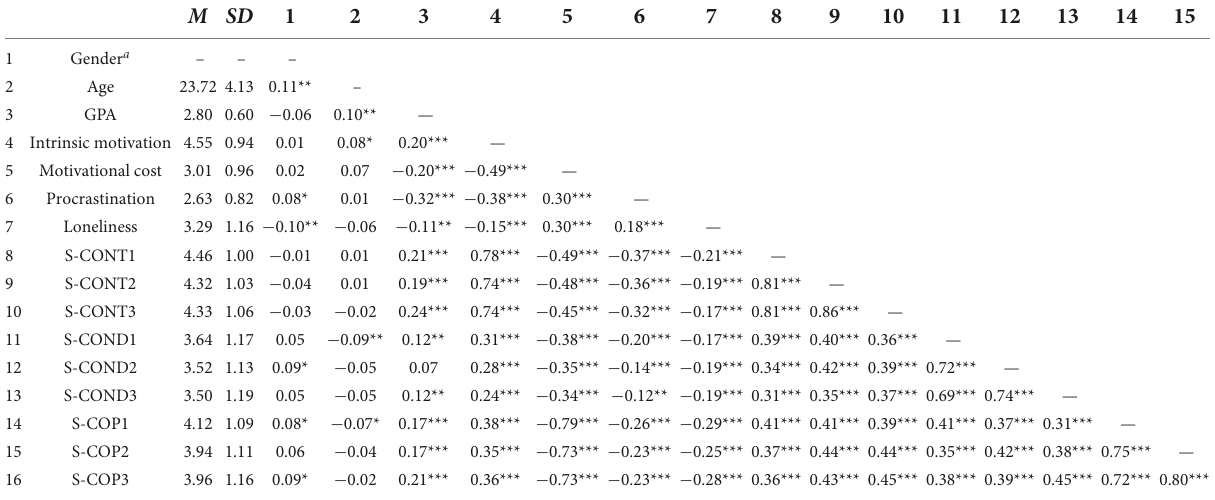
TABLE 1 Means, standard deviations, and correlations between sociodemographics, predictor variables and subdimensions of study satisfaction in study 1.